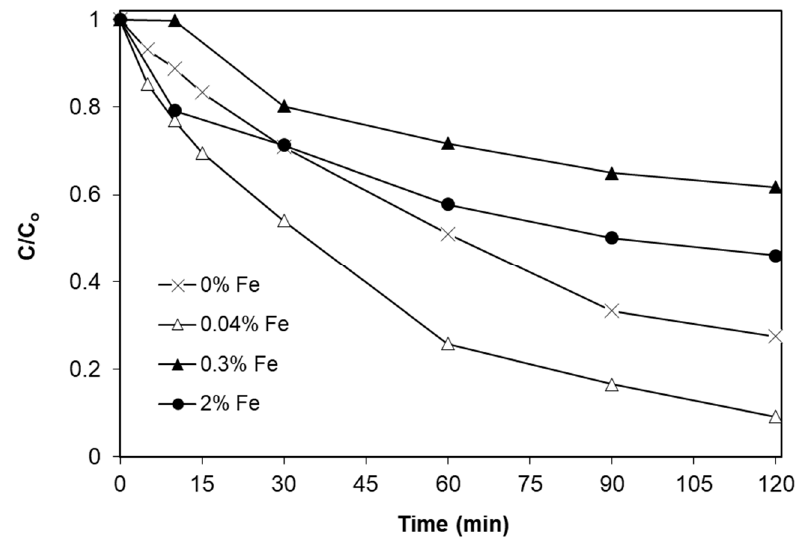
Figure 4. Effect of iron loading on the photocatalytic degradation of sulfamethoxazole (SMX) in ultrapure water (UPW). [SMX] = 234 μ g/L, [Fe/TiO 2 ] = 1 g/L and natural pH.